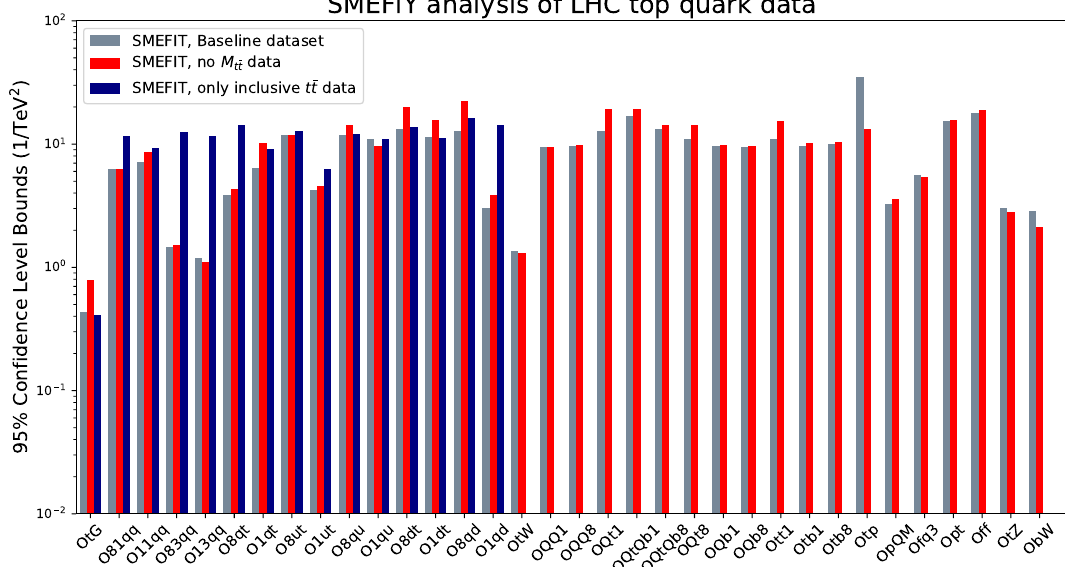
Figure 22 . Same as (cid:12)gure 19, now comparing the (cid:12)t results based on the baseline dataset with those obtained from two di(cid:11)erent datasets. In the (cid:12)rst case, for the t (cid:22) t production measurements, instead of the m distributions as indicated in table 7 we use the corresponding y t (cid:22) t In the second case, the (cid:12)t is performed only using inclusive t (cid:22) t production measurements as